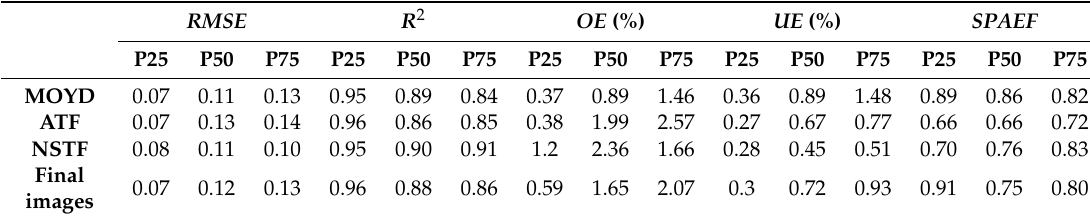
Figure 10. Gap-filling procedure for January 2004. ( a ) Selected “cloud-free” true MODIS SCF image. ( b1 , c1 , d1 ) Extracted mask images with cloud conditions of P25, P50, and P75. ( b2 , c2 , d2 ) The corresponding artificially cloud-filled images. The third to fifth rows represent the consecutive applications of MOYD, ATF, and NSTF. Table 4. Quantitative performance evaluation results for the one-day cloud